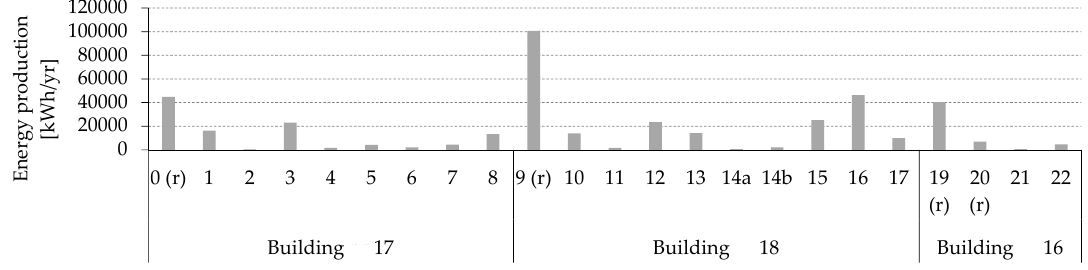
Figure 18. Solar energy generation on roofs (r) and façades in the critical area for the existing situation.